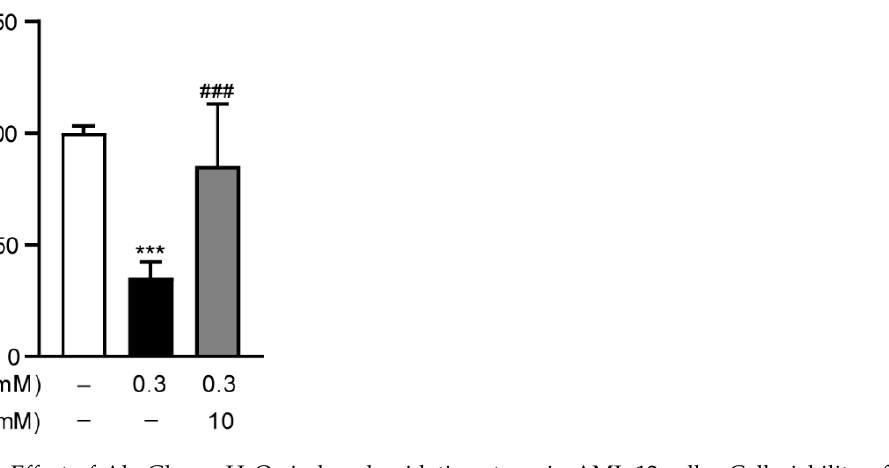
Figure 8. Effect of Ala ‐ Gln on H 2 O 2 ‐ induced oxidative stress in AML ‐ 12 cells. ( A ) Cell viability of AML ‐ 12 cells that had received H 2 O 2 stimulation (0.3 mM) and Ala ‐ Glu treatment (10 mM). Data are expressed as mean ± SD. *** p < 0.001 vs. vehicle ‐ treated control group, ### p < 0.001 vs. H 2 O 2 ‐ treated model group.